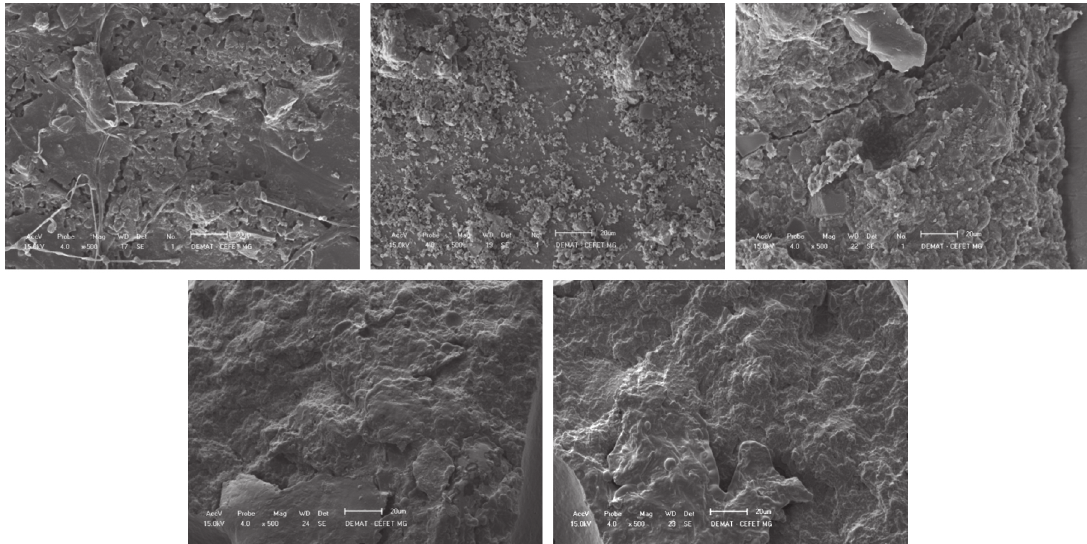
Figure 3. Microscopic images of the enamel surfaces after debonding of the brackets and their remaining adhesive. A - group G1 ; B - group G2 ; C - group G3 ; D - group G4 ; and E - group G5